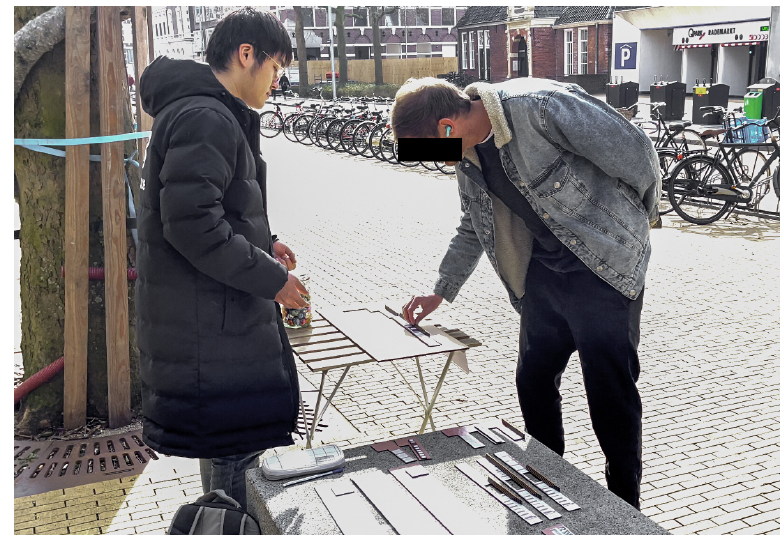
Figure 6. One participant playing the game (photo by Baoky. King. Yang. Huang).